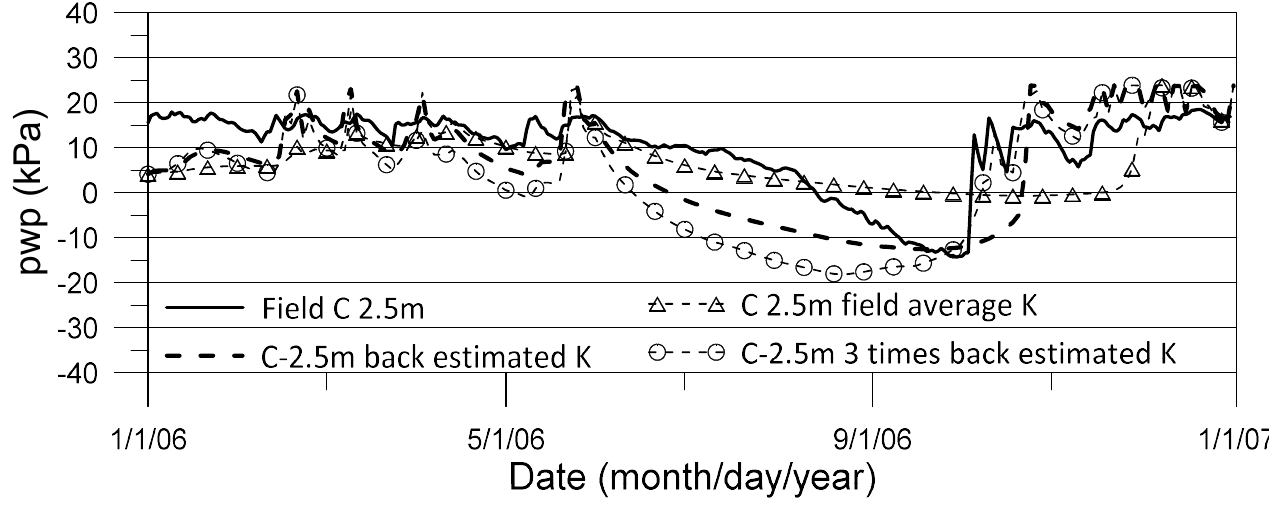
Figure 9. Different trial K sat values and related pore water pressure at Section C 2.5 m depth from the surface.